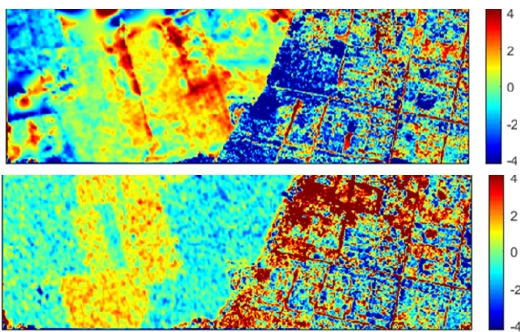
Figure 10. TanDEM-X height errors: Correlation between RMSE of height residuals and mean HEM value in different subsets